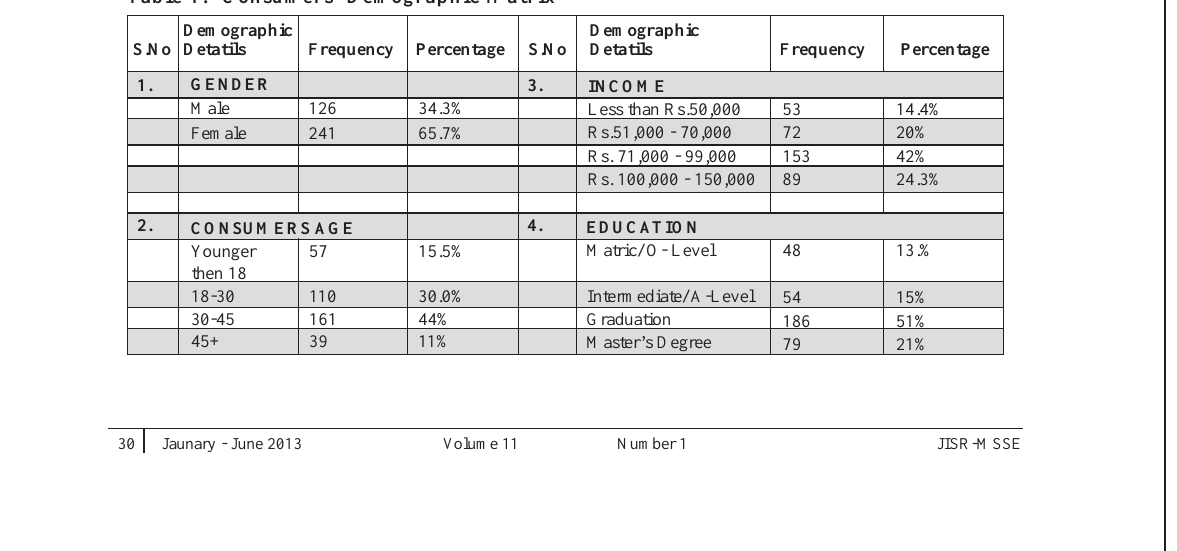
Table 1: Consumers’ Demographic